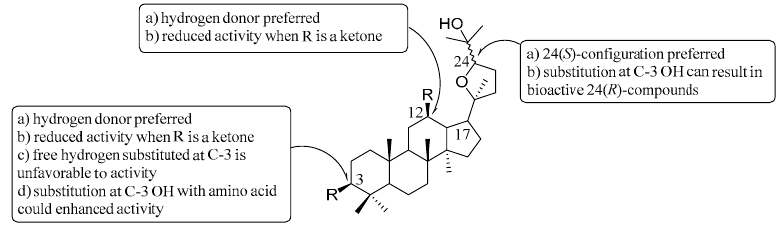
Figure 2. Structure ‐ activity relationships (SARs) of ocotillol ‐ type derivatives. Figure 2. Structure-activity relationships (SARs) of ocotillol-type derivatives.